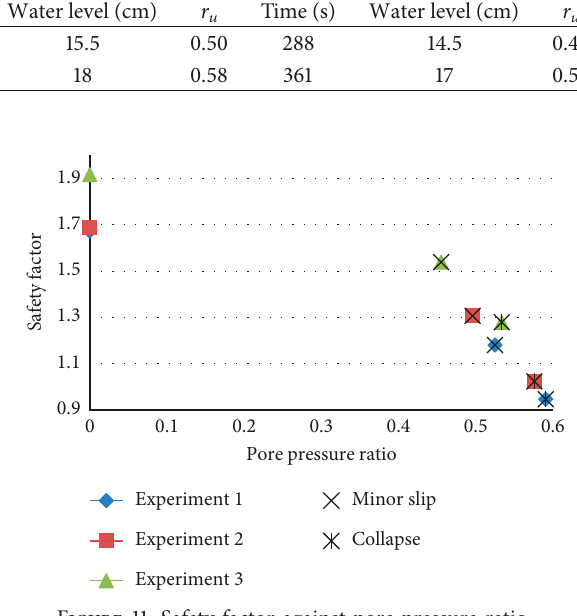
Figure 11: Safety factor against pore pressure ratio.